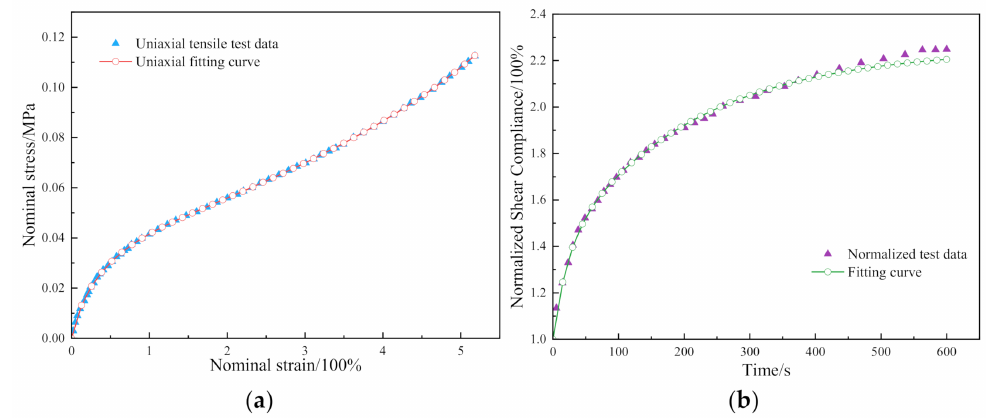
Figure 2. ( a ) The fitting result of the OCA for the Ogden model; ( b ) the fitting result of the OCA for the Prony model.